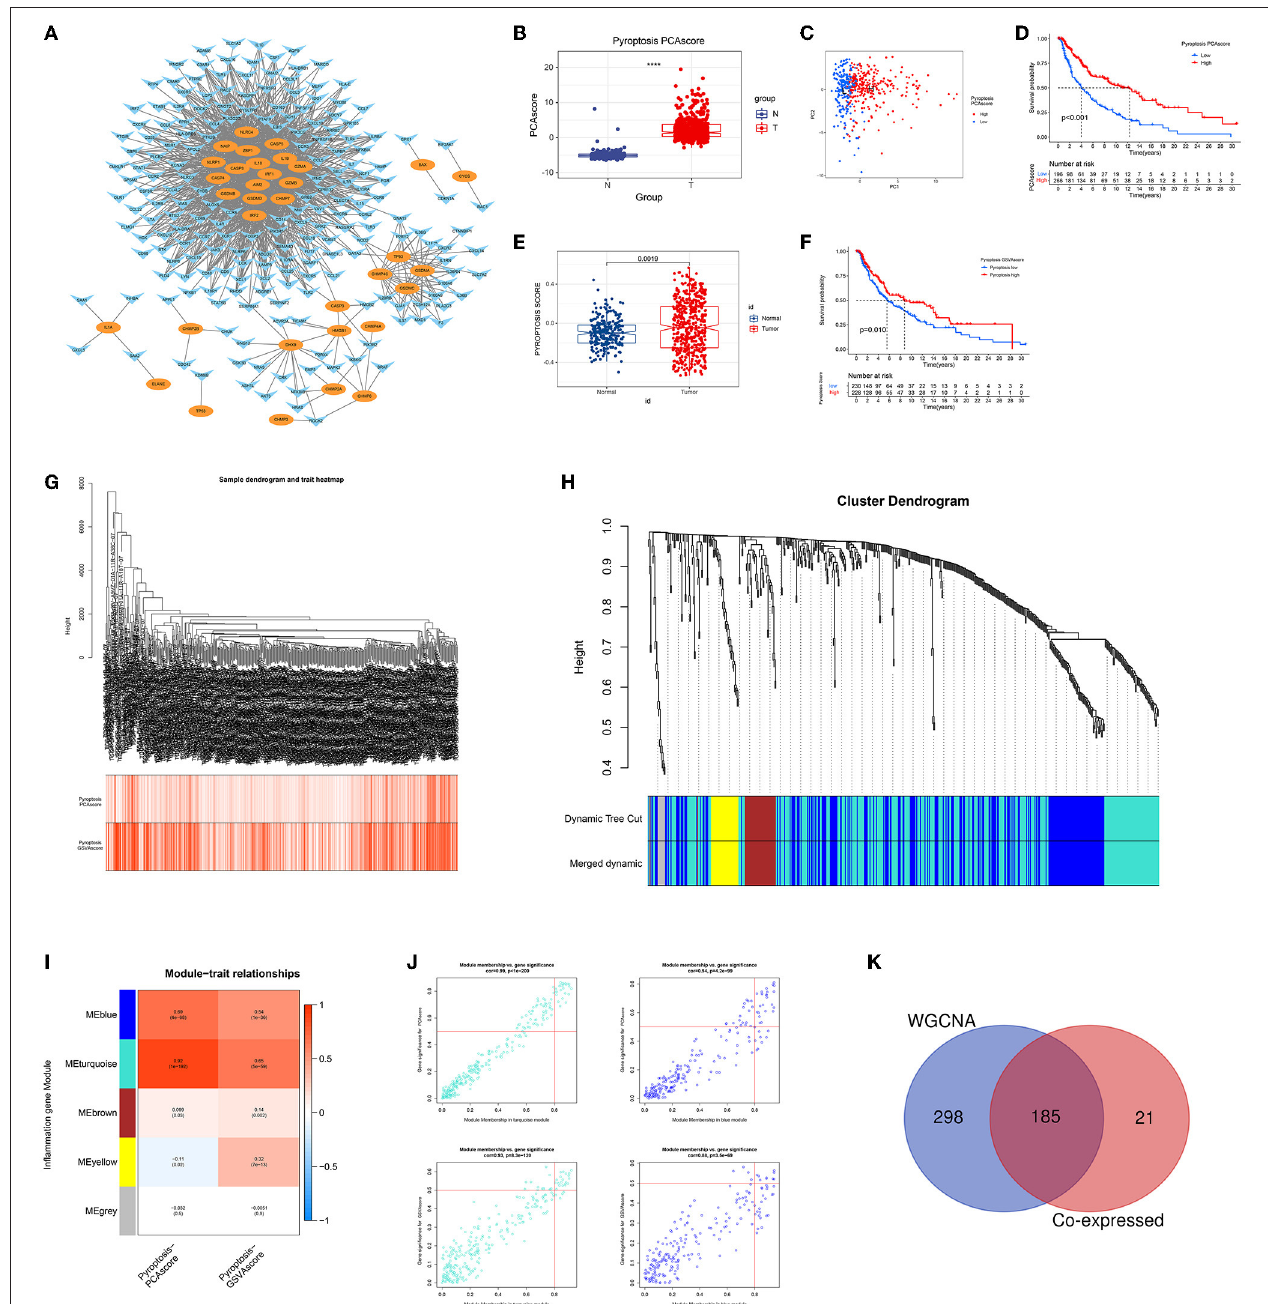
FIGURE 1 | Identification of GRIPs. (A) The co-expression network of pyroptosis-related genes and inflammation-related genes. Oval: pyroptosis genes; horn: inflammatory genes. (B) CM had higher PCA pyroptosis scores than normal samples. (C) Visualization of high and low PCA pyroptosis scores. (D) Kaplan-Meier analysis showed that patients with high PCA pyroptosis scores had a higher survival probability. (E) CM had a higher GSVA pyroptosis score than normal samples. (F) Kaplan-Meier analysis showed that patients with high GSVA pyroptosis scores had a higher survival probability. (G–J) WGCNA identified pyroptotic inflammatory modules (ME blue and ME turquoise) based on the PCA and GSVA pyroptosis scores. (K) A Venn diagram illustrates that the co-expression network analysis and WGCNA have 185 overlapped genes, which are candidate GRIPs for constructing gene signature.